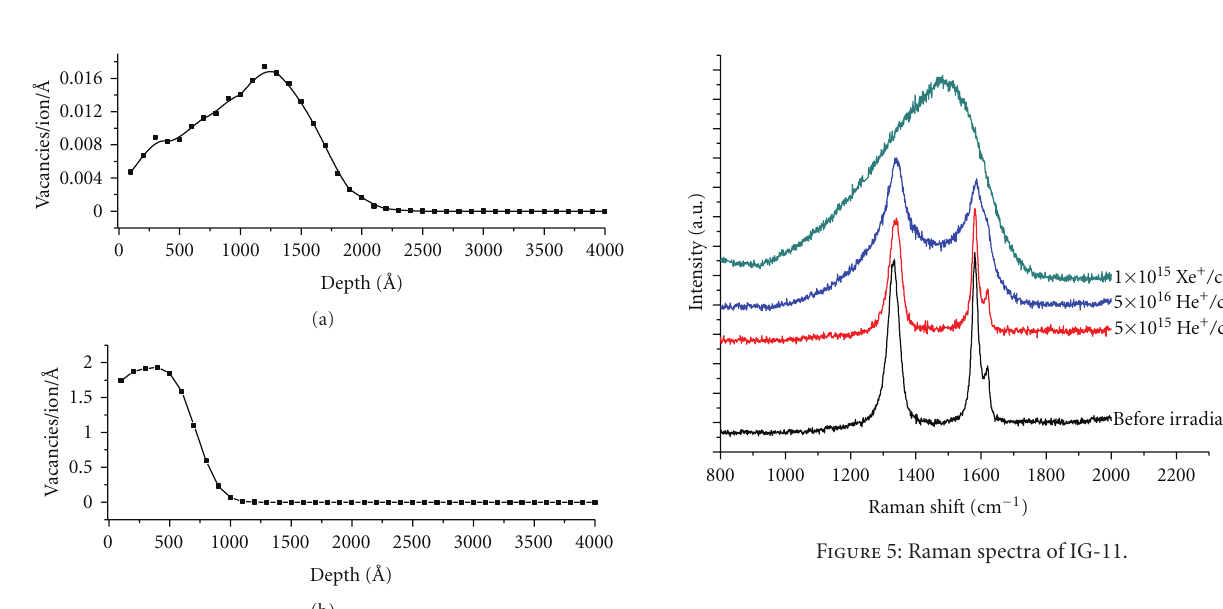
150 μ m, and the maximum diameter is about 200 μ m; HSM- SC has 31 pores bigger than 200 μ m, with maximum diame- ter reaching up to 330 μ m.